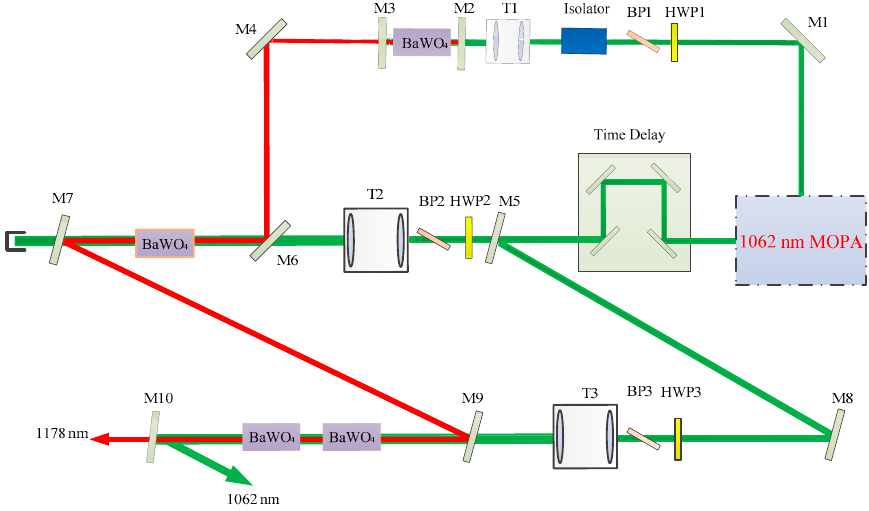
Figure 1. Schematic of single-frequency BaWO 4 Raman master oscillator power amplifier.